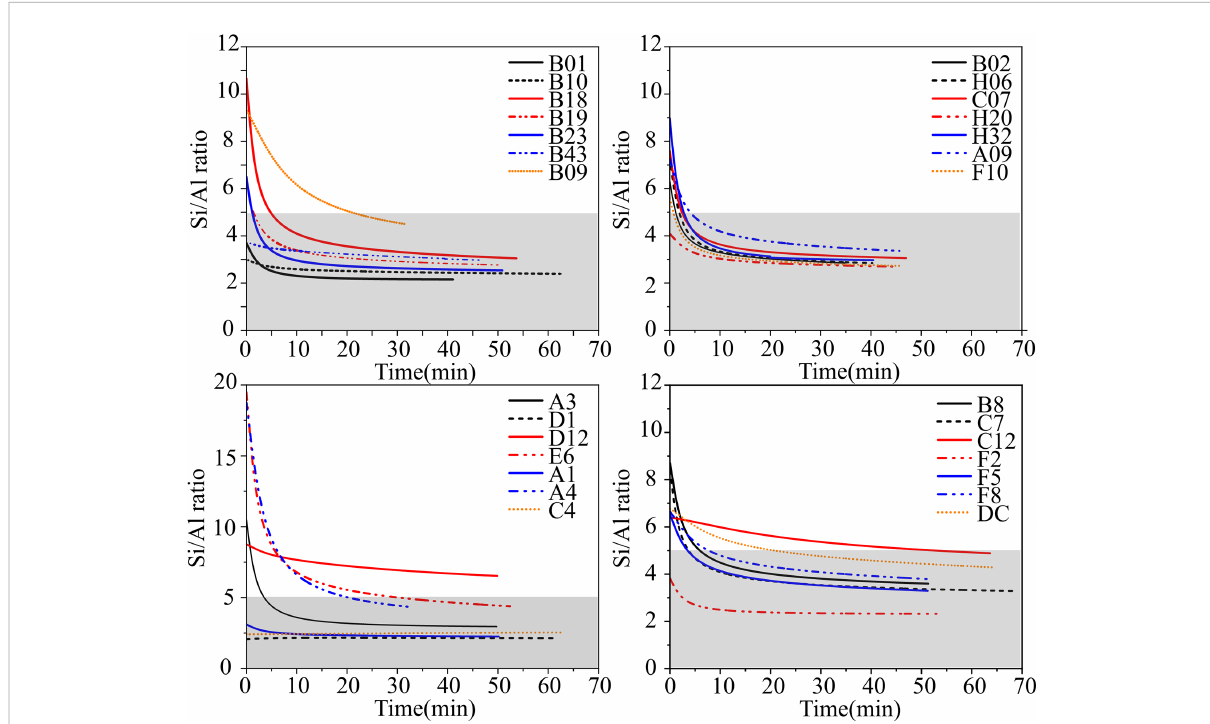
FIGURE 5 The Si:Al ratio during alkaline digestion. Sediments were digested following the method described in Koning et al. (2002) and Barão et al. (2015). The grey area represents the Si:Al below 5, indicating the extraction of